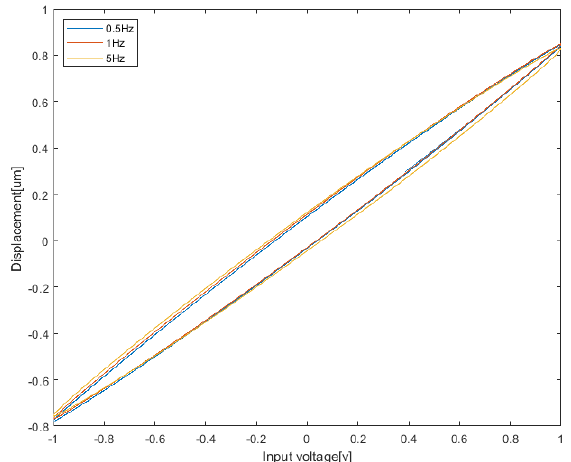
Figure 5. Hysteresis characteristics of PEA at low frequency.